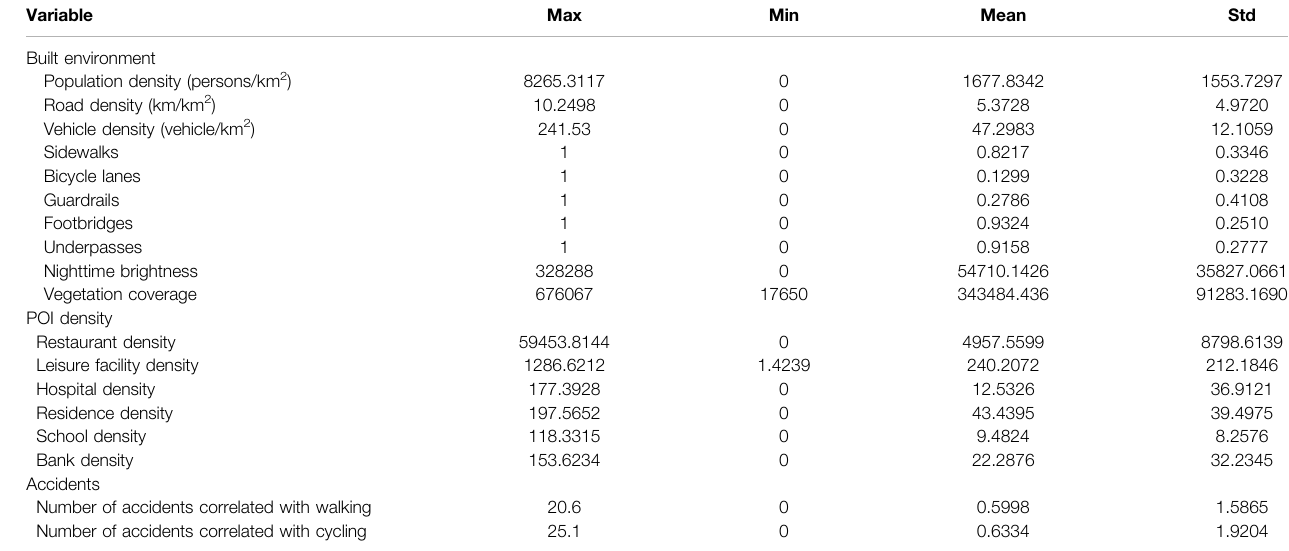
TABLE 1 | Data description. Variable